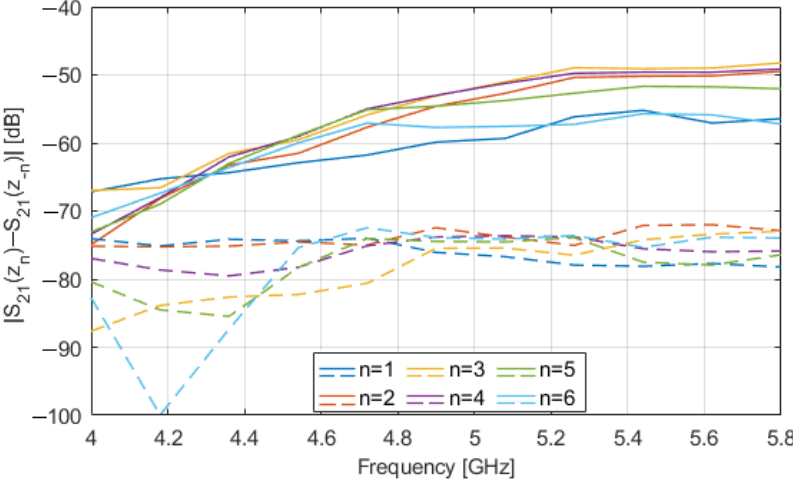
Figure 7. Simulated |S 21 (z n ) − S 21 (z − n )| (in dB) vs. frequency: OUT with an 8 mm glass inclusion (solid lines); OUT free of inclusions (dashed lines).